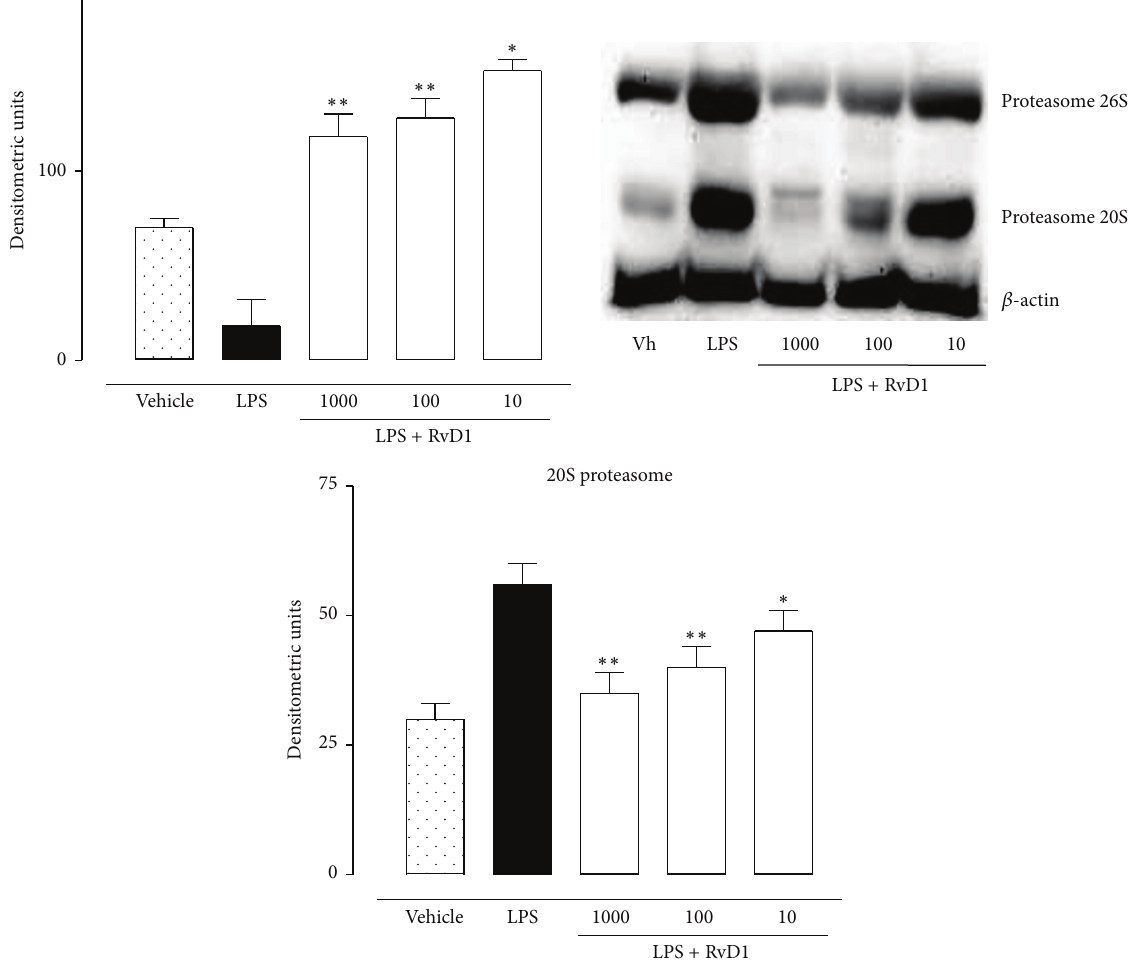
Figure 8: Western Blotting showing that Resolvin D1 (RvD1) treatment reduces the ocular proteasome system. Ocular tissue homogenates from the eyes of LPS-treated rats showed highest levels of 20S and 26S proteasome subunits. Intravitreal RvD1 (10-100-1000ng/kg) post-LPS decreased the levels of the proteasome subunits with the respect to LPS alone. Results are expressed as densitometric units and represented the mean ± SEM of 𝑛 = 6 observation for each group. Vh = vehicle; ∗ 𝑃 < 0.05 and ∗∗ 𝑃 < 0.01 versus LPS.